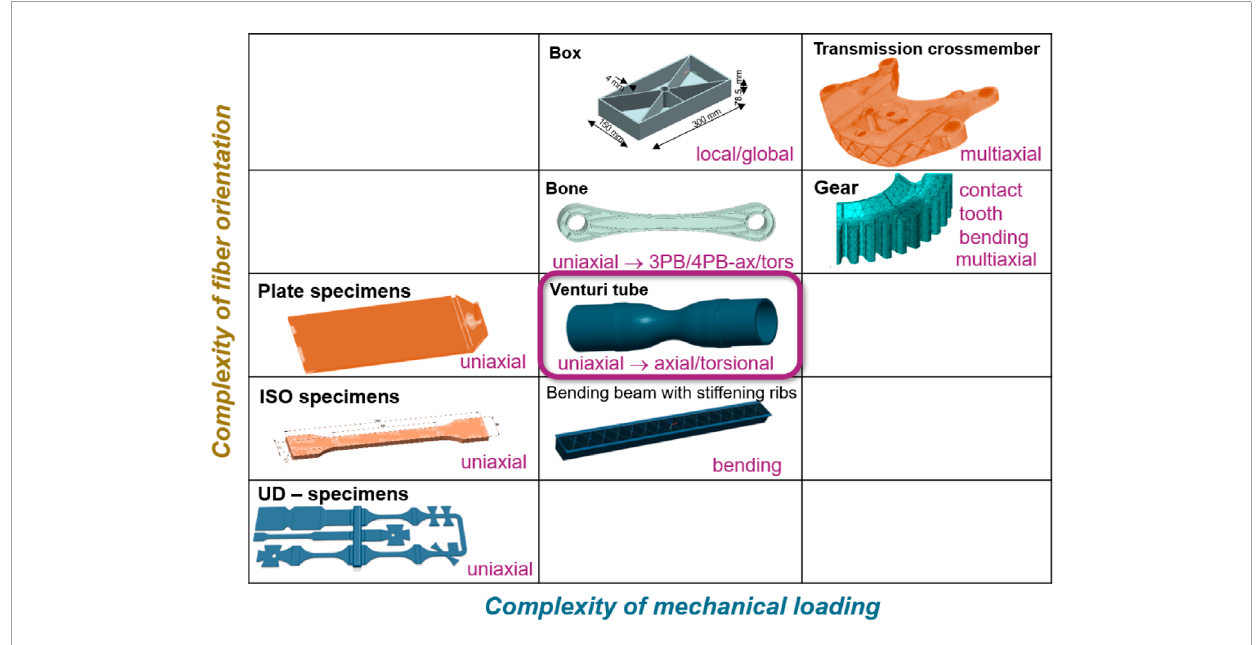
FIGURE 1 Complexity map for injection molded short fiber reinforced specimens and composites.